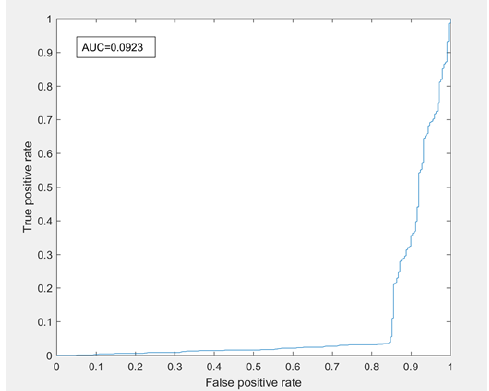
Figure 8. ROC curve for UAV images